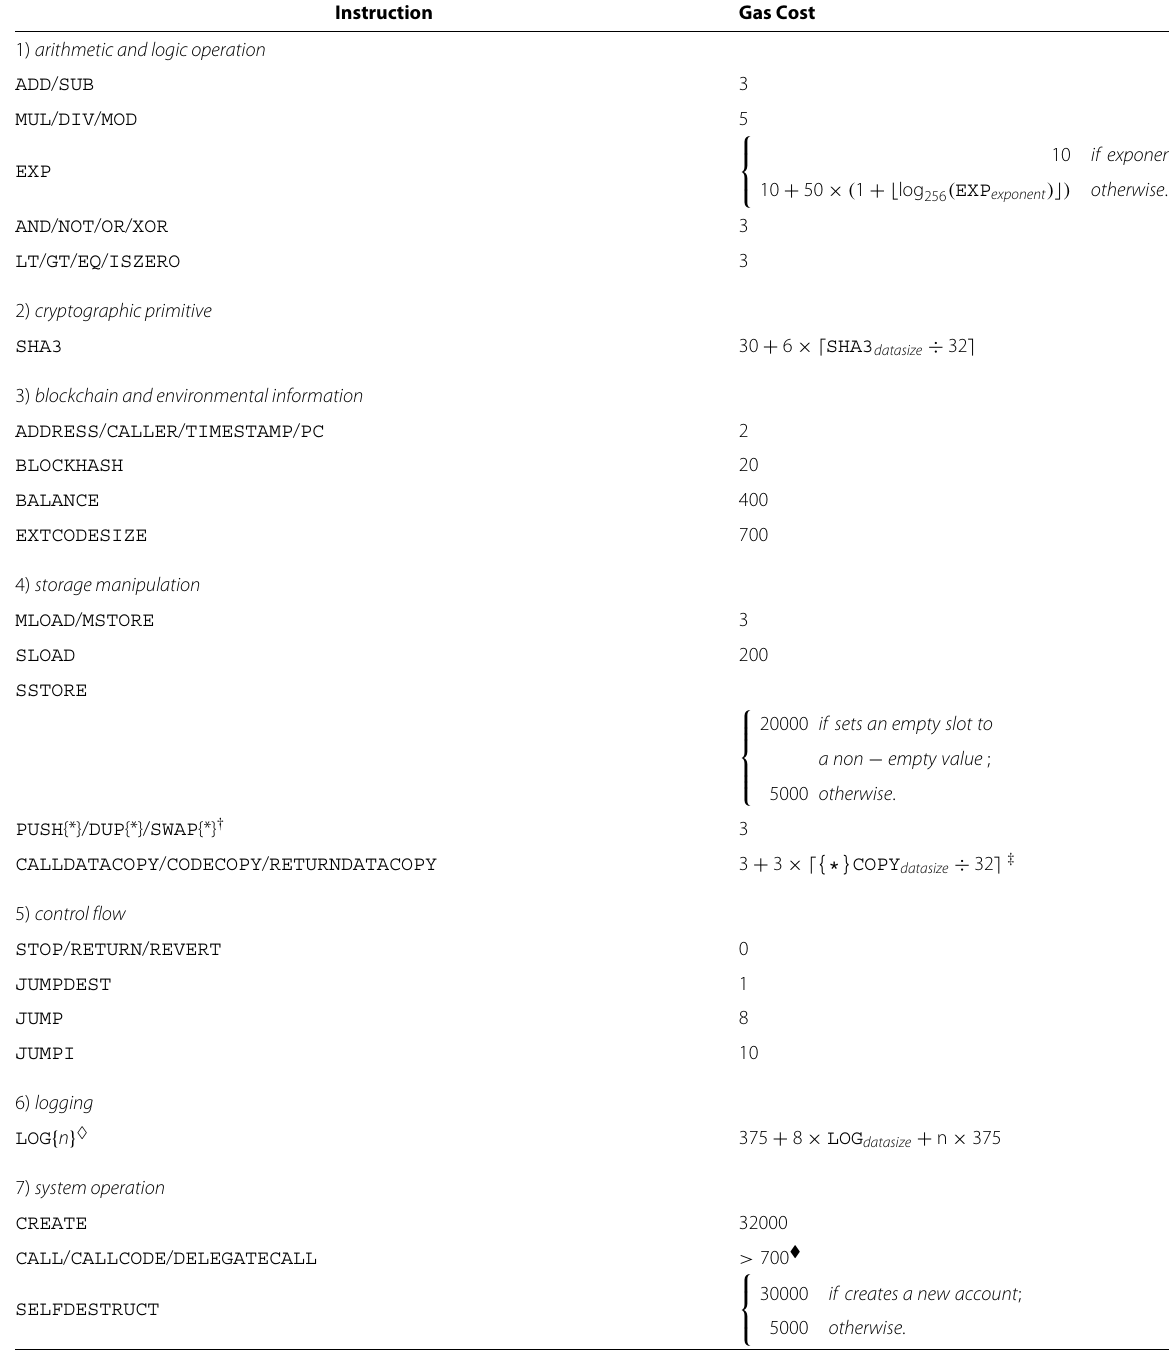
Table 1 A selected list of EVM instructions, along with their gas cost (not including memory expansion cost), as of St. Petersburg hardfork, February 28th, 2019